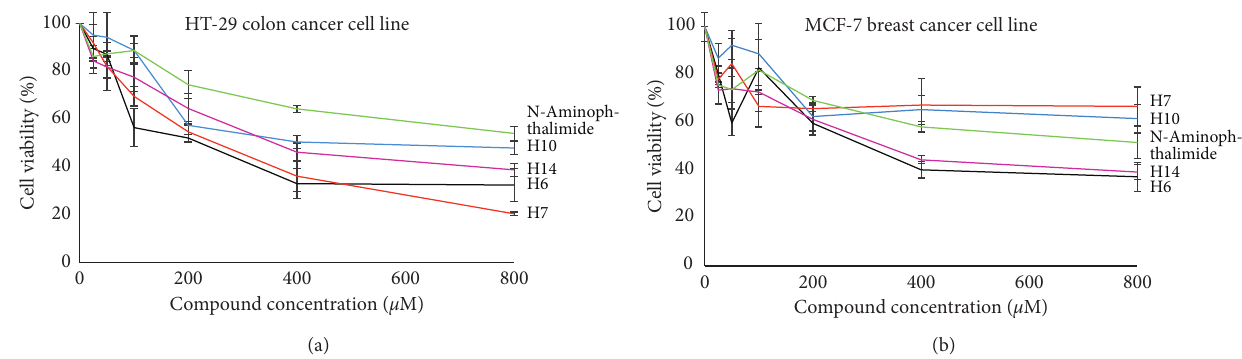
Figure 4: Anticancer activities of selected active imines. (a) Colon cancer HT-29 cell line viability. (b) Breast cancer MCF-7 cell line viability, after treatment with imines for 24